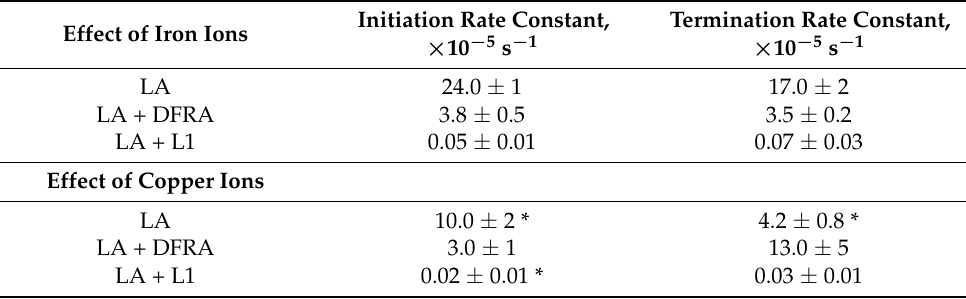
Table 2. Initiation and termination rate constants of the reactions of linoleic acid (LA) peroxidation induced by iron and copper ions in the absence and in the presence of deferasirox (DFRA) and deferiprone